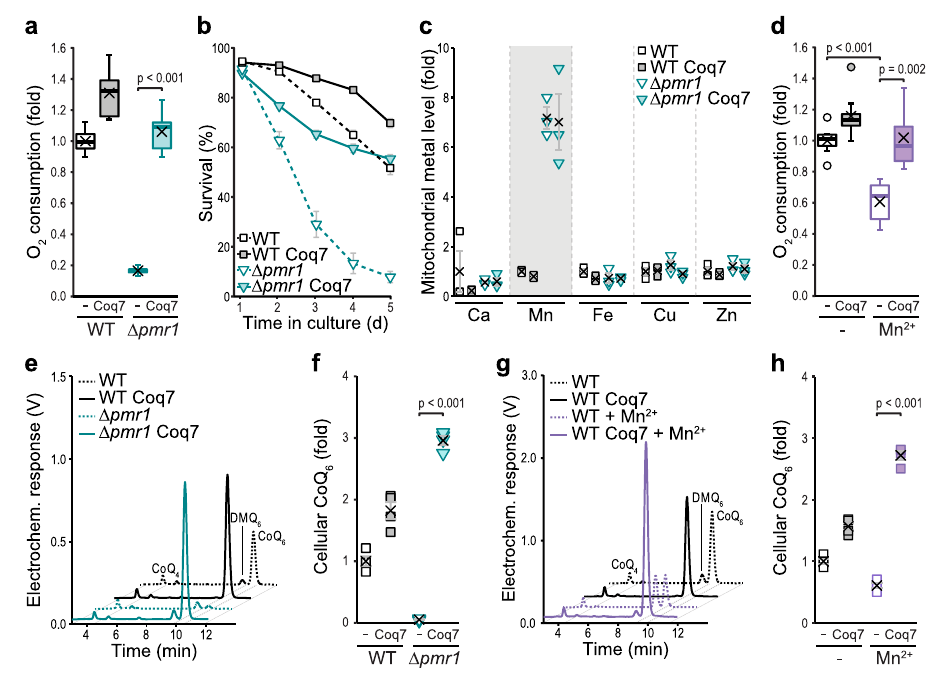
Fig. 3 | Overexpression of Coq7 prevents Mn-driven respiratory failure and restoresCoQlevels.a Polarographicquanti fi cationofoxygenconsumptionofWT and Δ pmr1 cells overexpressing Coq7 or harboring the vector control. n =8. b Survival of WT and Δ pmr1 cells overexpressing Coq7 or harboring the vector control determined via fl ow cytometric evaluation of propidium iodide staining. Means±SEM, n =8. c Metal content of mitochondria isolated from WT and Δ pmr1 cells overexpressing Coq7 or harboring the vector control determined via TXRF. Means±SEM, n =3. d Oxygen consumption of WT cells overexpressing Coq7 or harboring the vector control grown in glucose media with or without 5mM MnCl 2 for24h. n =8. e , f TotalcellularCoQcontentinlipidextractsofWTand Δ pmr1 cells